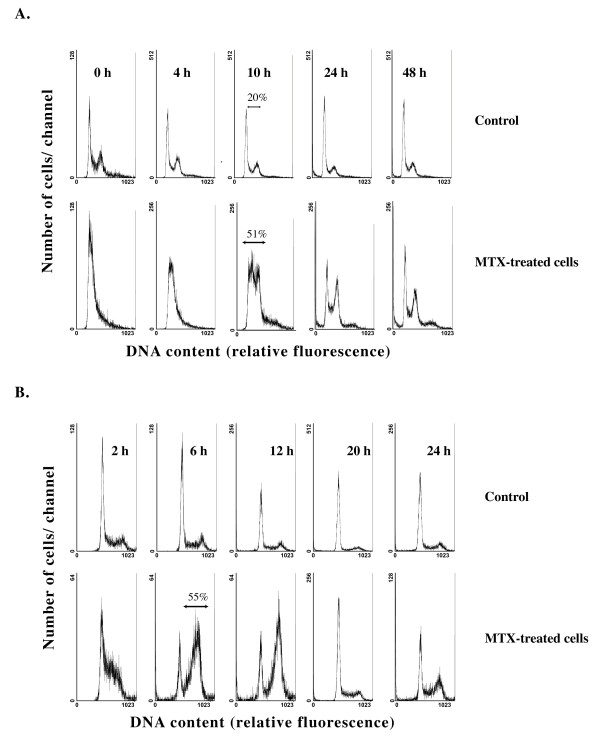
Distribution in cell cycle-phase after MTX treatment. Cell cycle phases of DHDK12 cells (A) and HT29 cells (B) were obtained by uniparametric flow cytometry analysis of DNA content (propidium iodide red-fluorescence intensity in fluorescence units) at various time after MTX removal. On the ordinate is shown the number of cells corresponding to the fluorescence units.